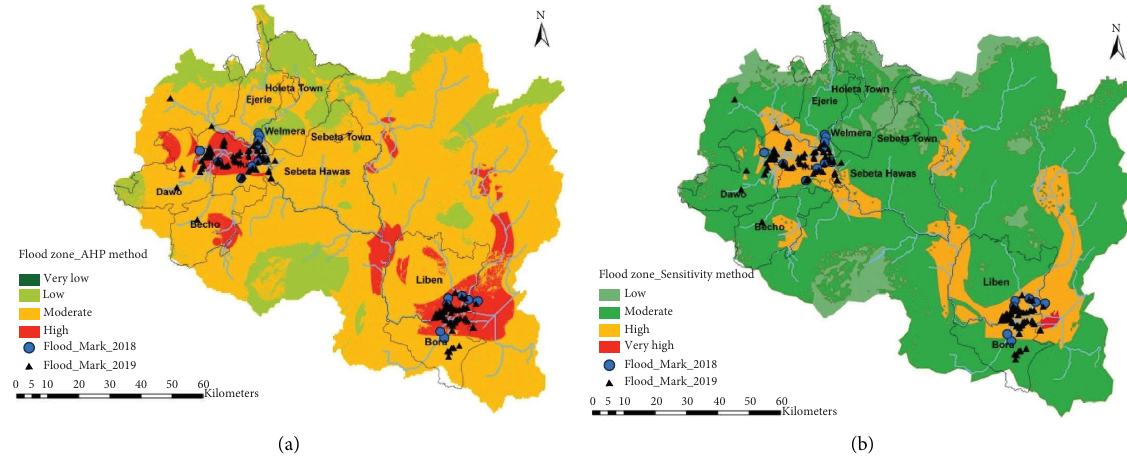
Figure 8: Overlaying collected food marks over the developed food